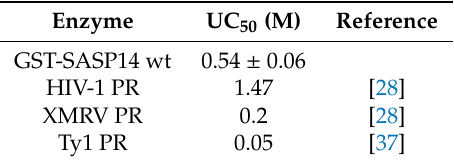
Table 2. Dimer stabilities of GST-SASP14 and retroviral proteases. References are shown for the values that have been published